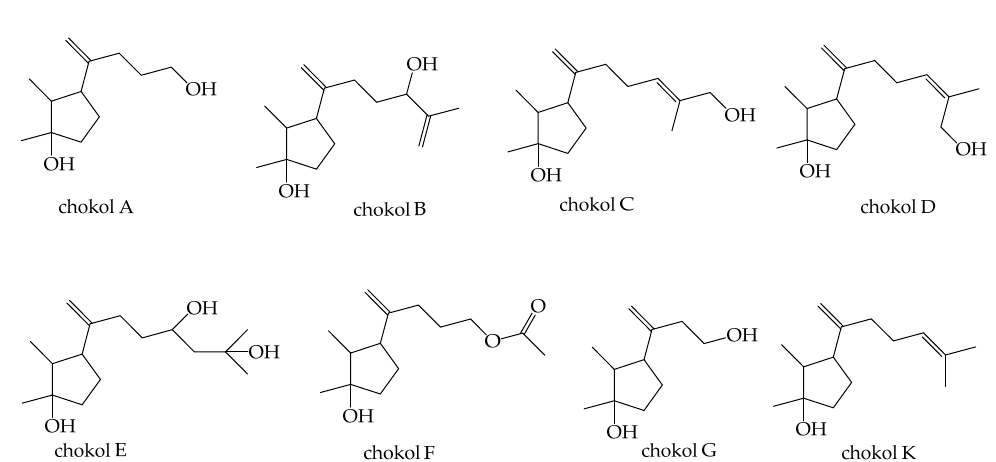
Figure 3. Structures of the fungitoxic compounds isolated from sexual Epichloë species that are listed and referenced in Table 3.